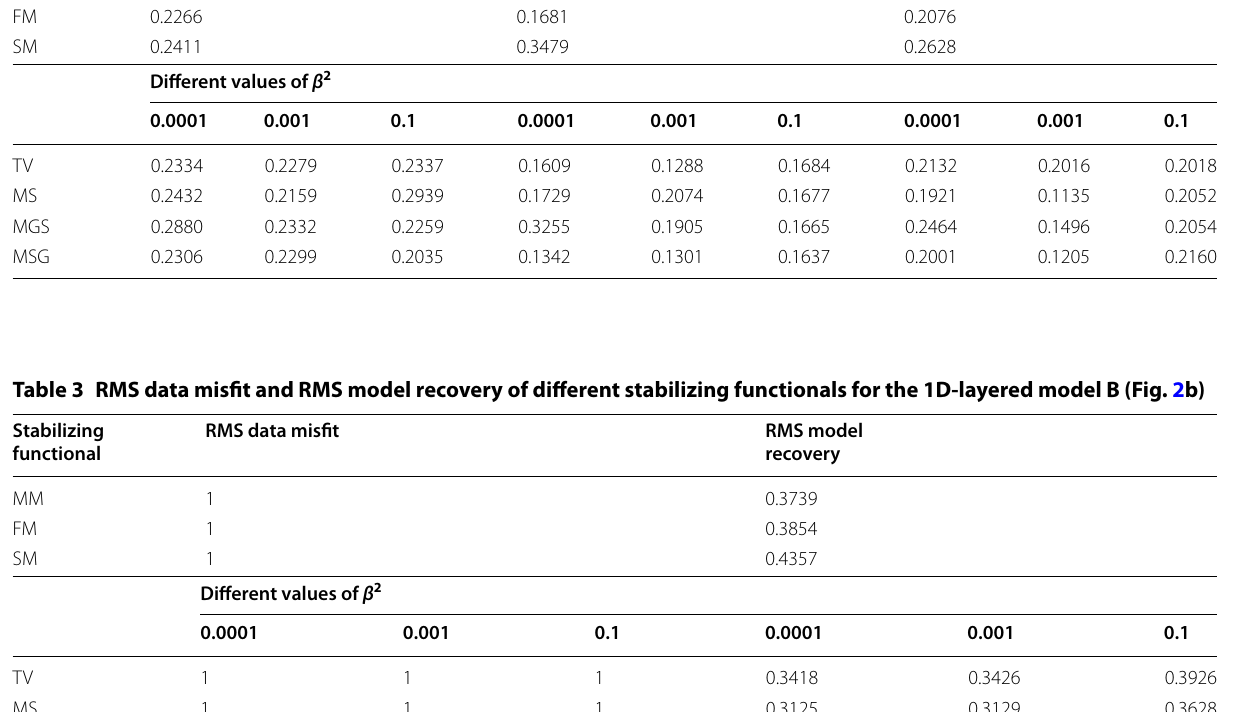
Table 2 RMS model recovery around each boundary of the 1D-layered model A (Fig. 2a) Stabilizing First boundary functional x from 1.5 to 0.5 − −